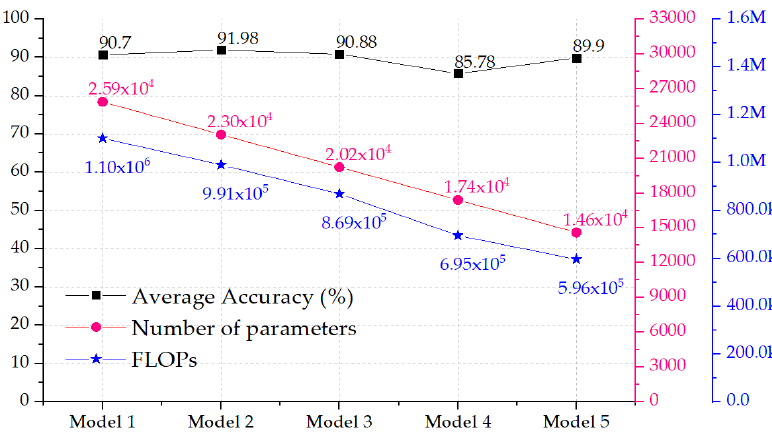
Figure 7. Comparison of the performance, number of trainable parameters, and FLOPS in the convolutional layers.